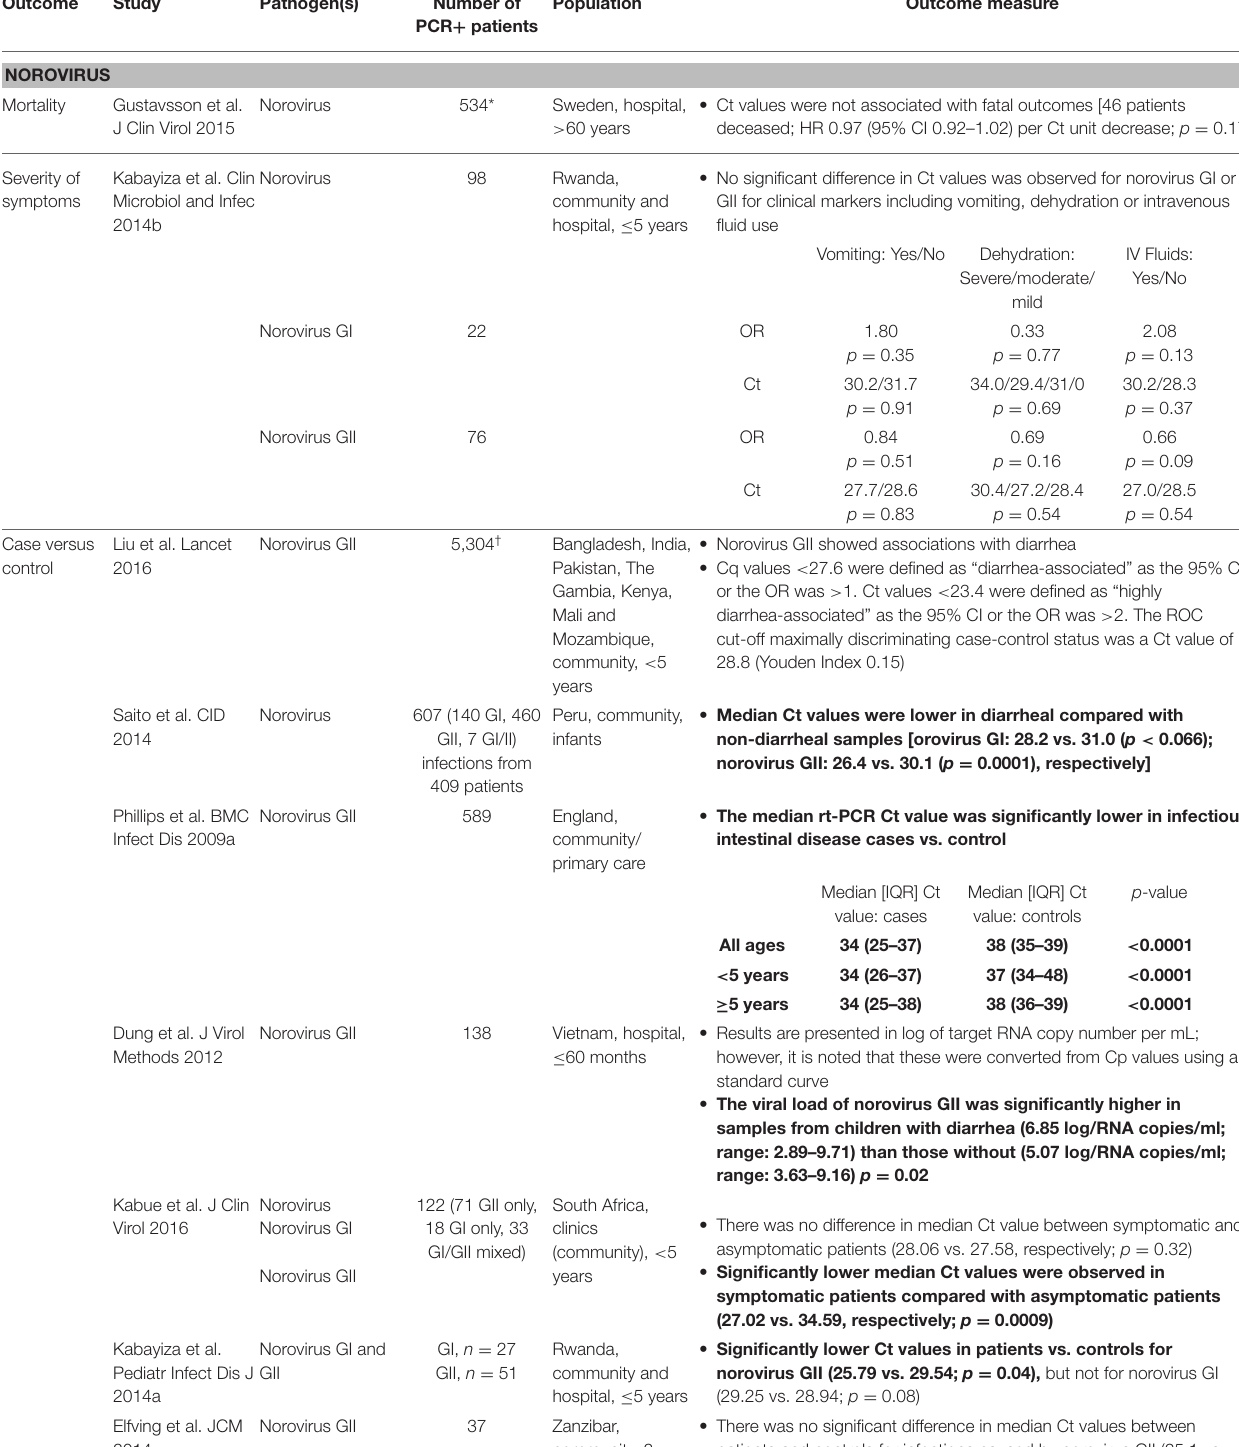
TABLE 2 | Summary of studies that assessed PCR Ct values for gastrointestinal viruses against patient clinical presentation and